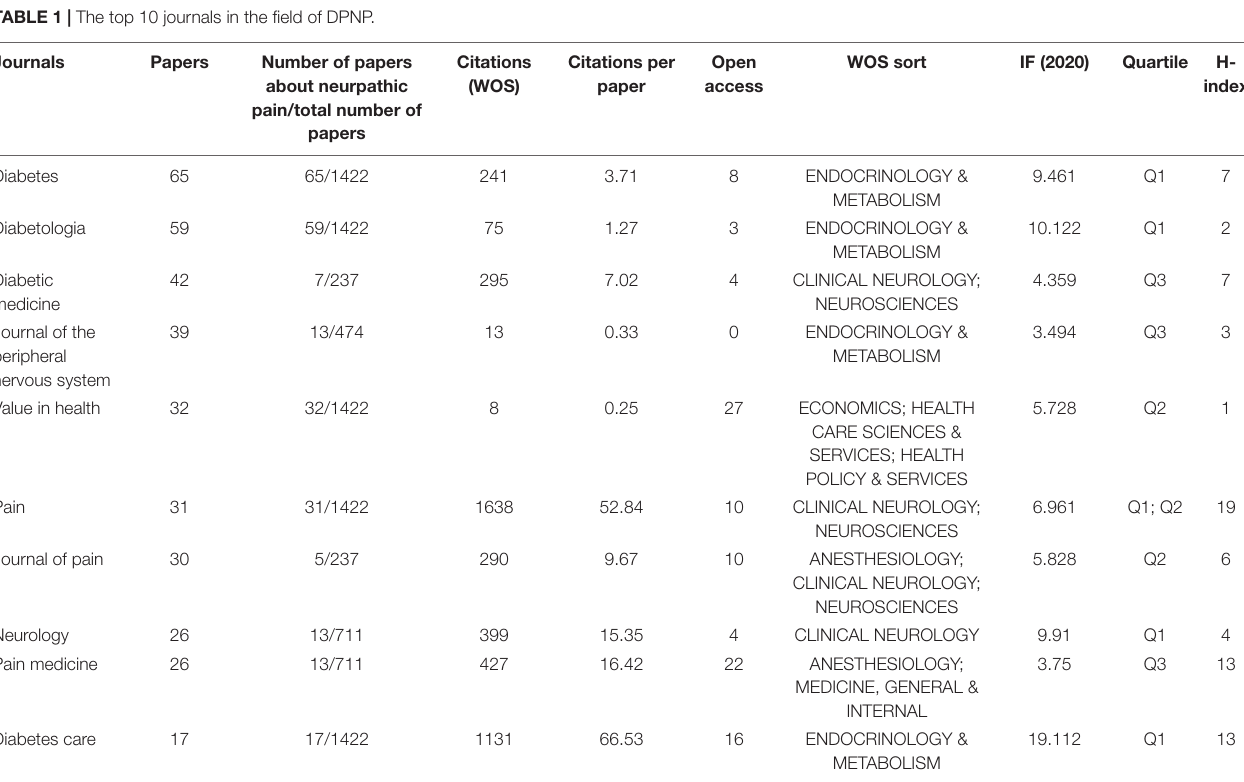
FIGURE 3 | The amounts of papers, citations, citations per paper, open access papers, and H-index of the top 10 subject sort of Web of Science. TABLE 1 | The top 10 journals in the field of